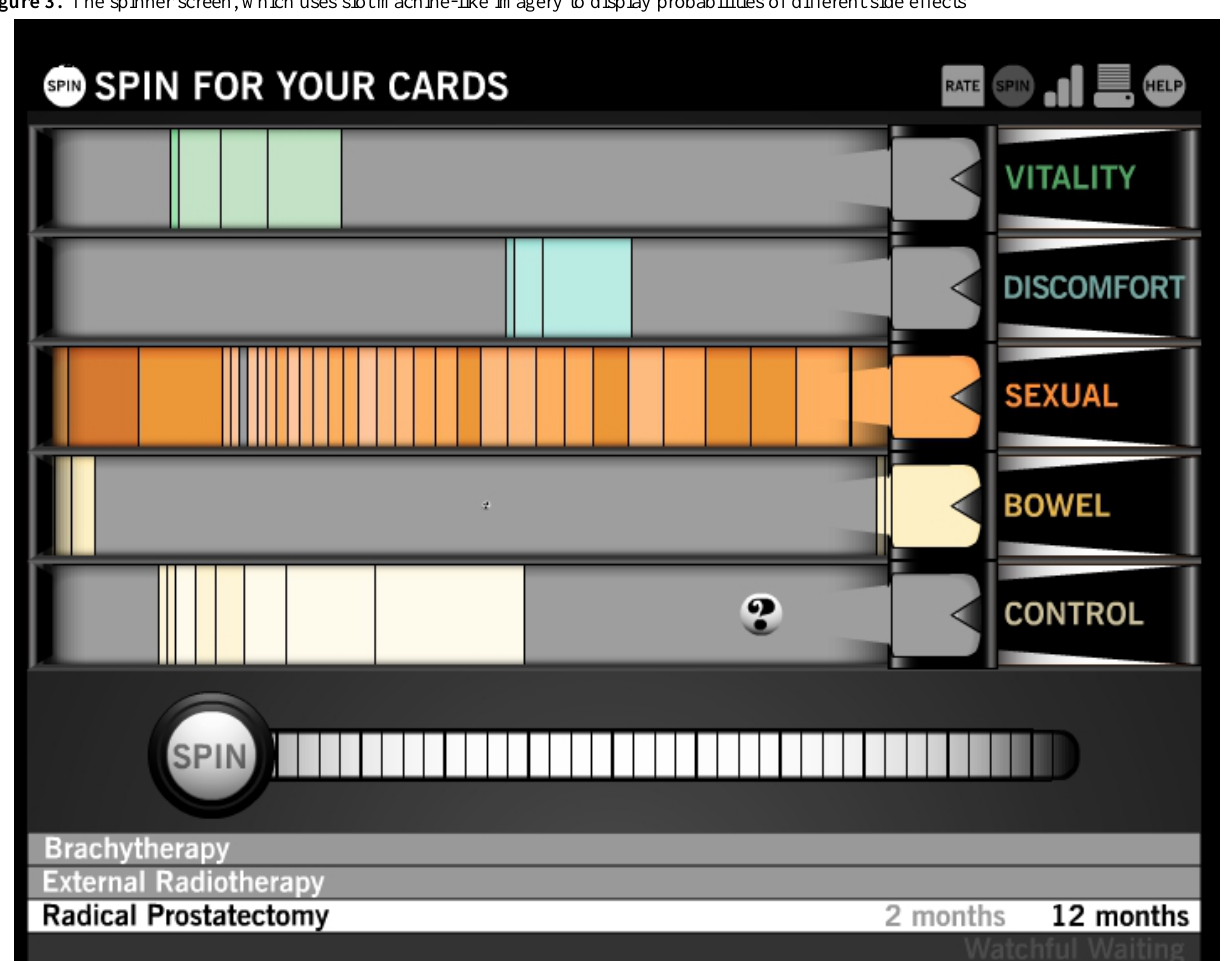
Figure 3. The spinner screen, which uses slot machine-like imagery to display probabilities of different side